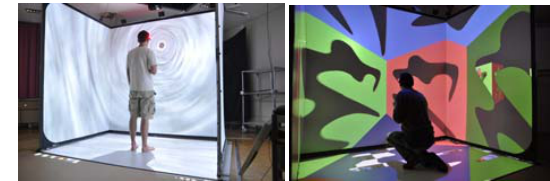
Figure 3. Four screens CAVE: the projection viewpoint is updated with the head location tracked with three active optical markers.